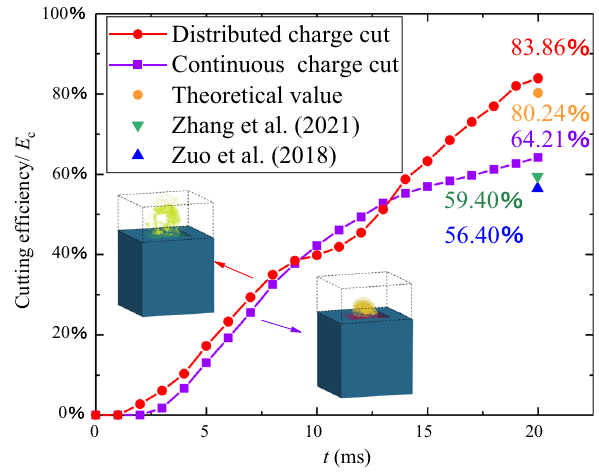
Fig. 14 Comparison of cut blasting efficiency under two charging modes